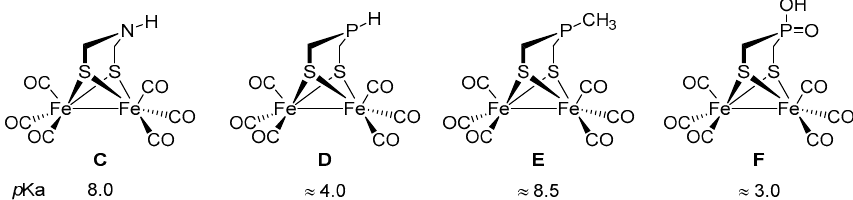
Figure 4. [FeFe]-hydrogenase model compounds comprising phosphadithiol bridgeheads D–F and the hexacarbonyl precursor of the native cofactor ADT, C. The known/expected pKa values are noted under each structure. pK a values for C are from ref. [16] . Approximated values for D–F are based on dimethylphosphine ( D ) [17], trimethylphosphine ( E ) [17] and dialkylphosphinic acids ( F ).